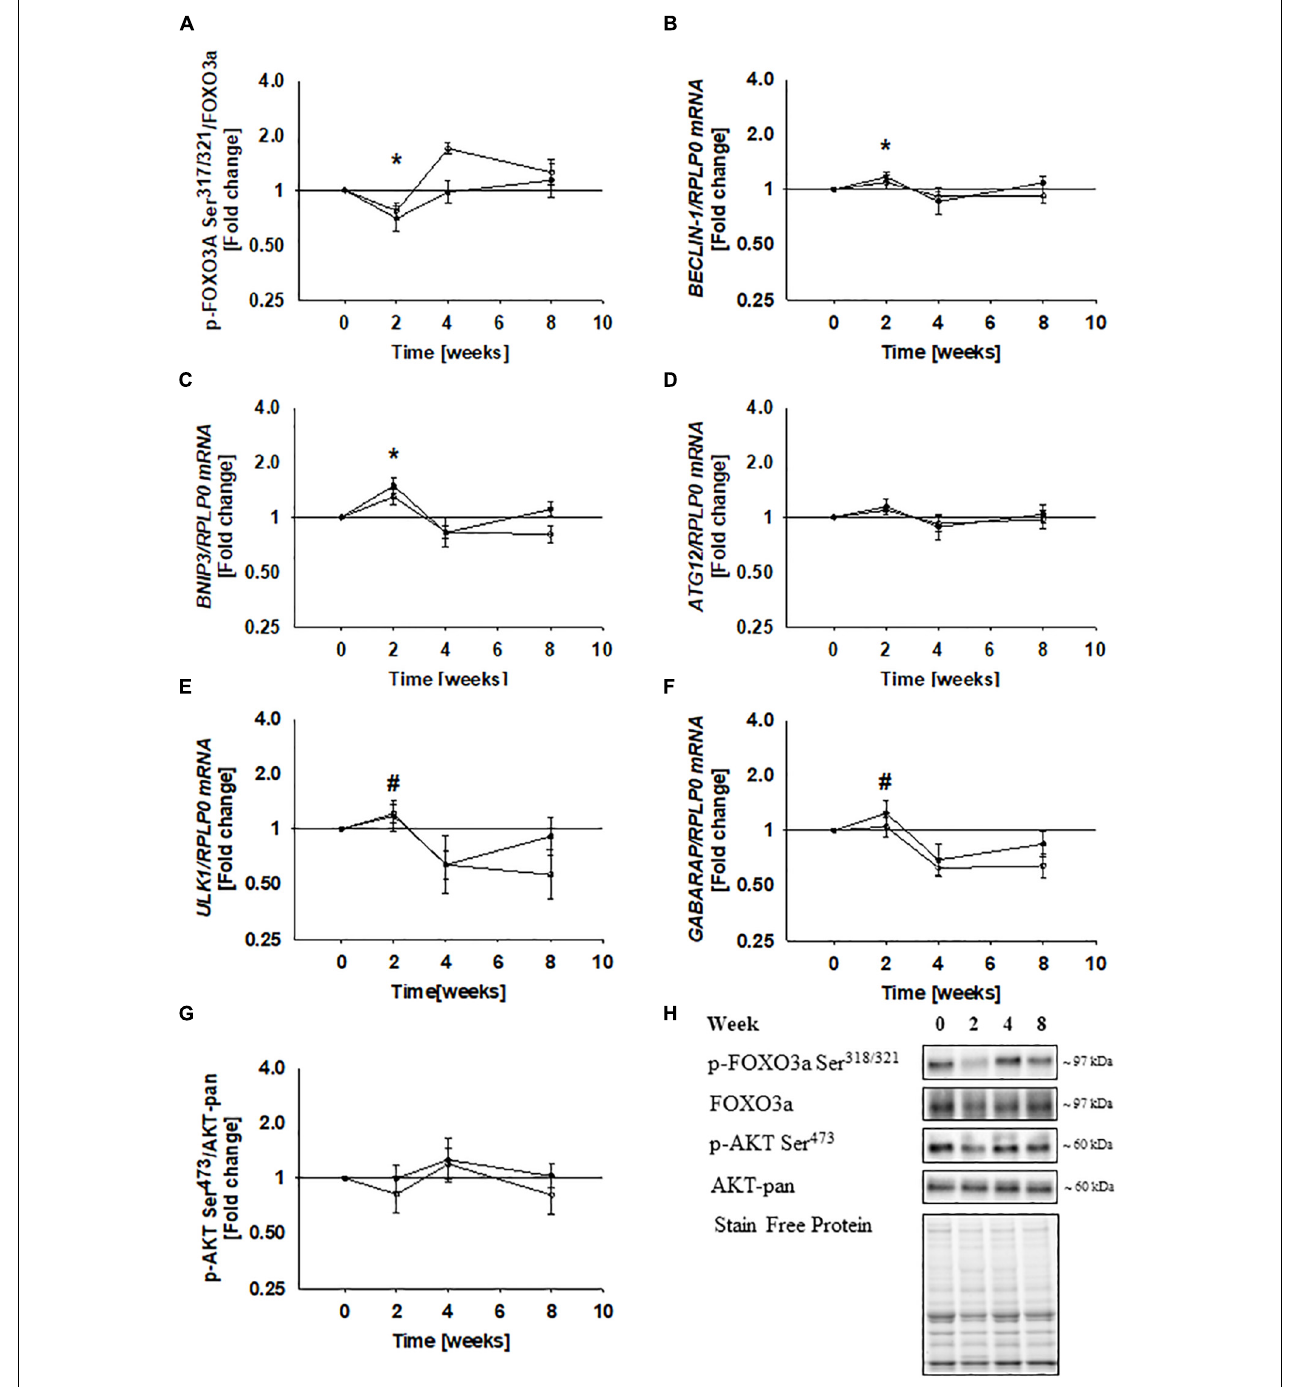
FIGURE 6 | Immobilization decreased FOXO3a phosphorylation at Ser 318 / 321 and increases mRNA expression of autophagy-related genes controlled by FOXO3a. FOXO3a phosphorylation at Ser 318 / 321 decreased during immobilization and increased to baseline level during rehabilitation (A) . mRNA expression of BECLIN-1 and BNIP3 increased during immobilization (B,C) , while the increase in ATG12, ULK1, and GABARAPL1 did not reach statistical significance (D–F) , although mRNA expression of BECLIN-1, BNIP3, ULK1, and GABARAPL1 decreased during rehabilitation (B–F) . mRNA expression of ATG12 remained unchanged during rehabilitation (D) AKT phosphorylation at Ser 473 remained unchanged during the study (G) . Values are geometric means ± back-transformed SE. ∗ Post hoc t -test showed significant change during immobilization. # Post hoc test showed significant change during rehabilitation. Representative western blots (H) . Based on the applied molecular standards, approximated molecular weights are indicated on the right. Filled symbols represent subjects from T0 and open symbols represent subjects from T2.